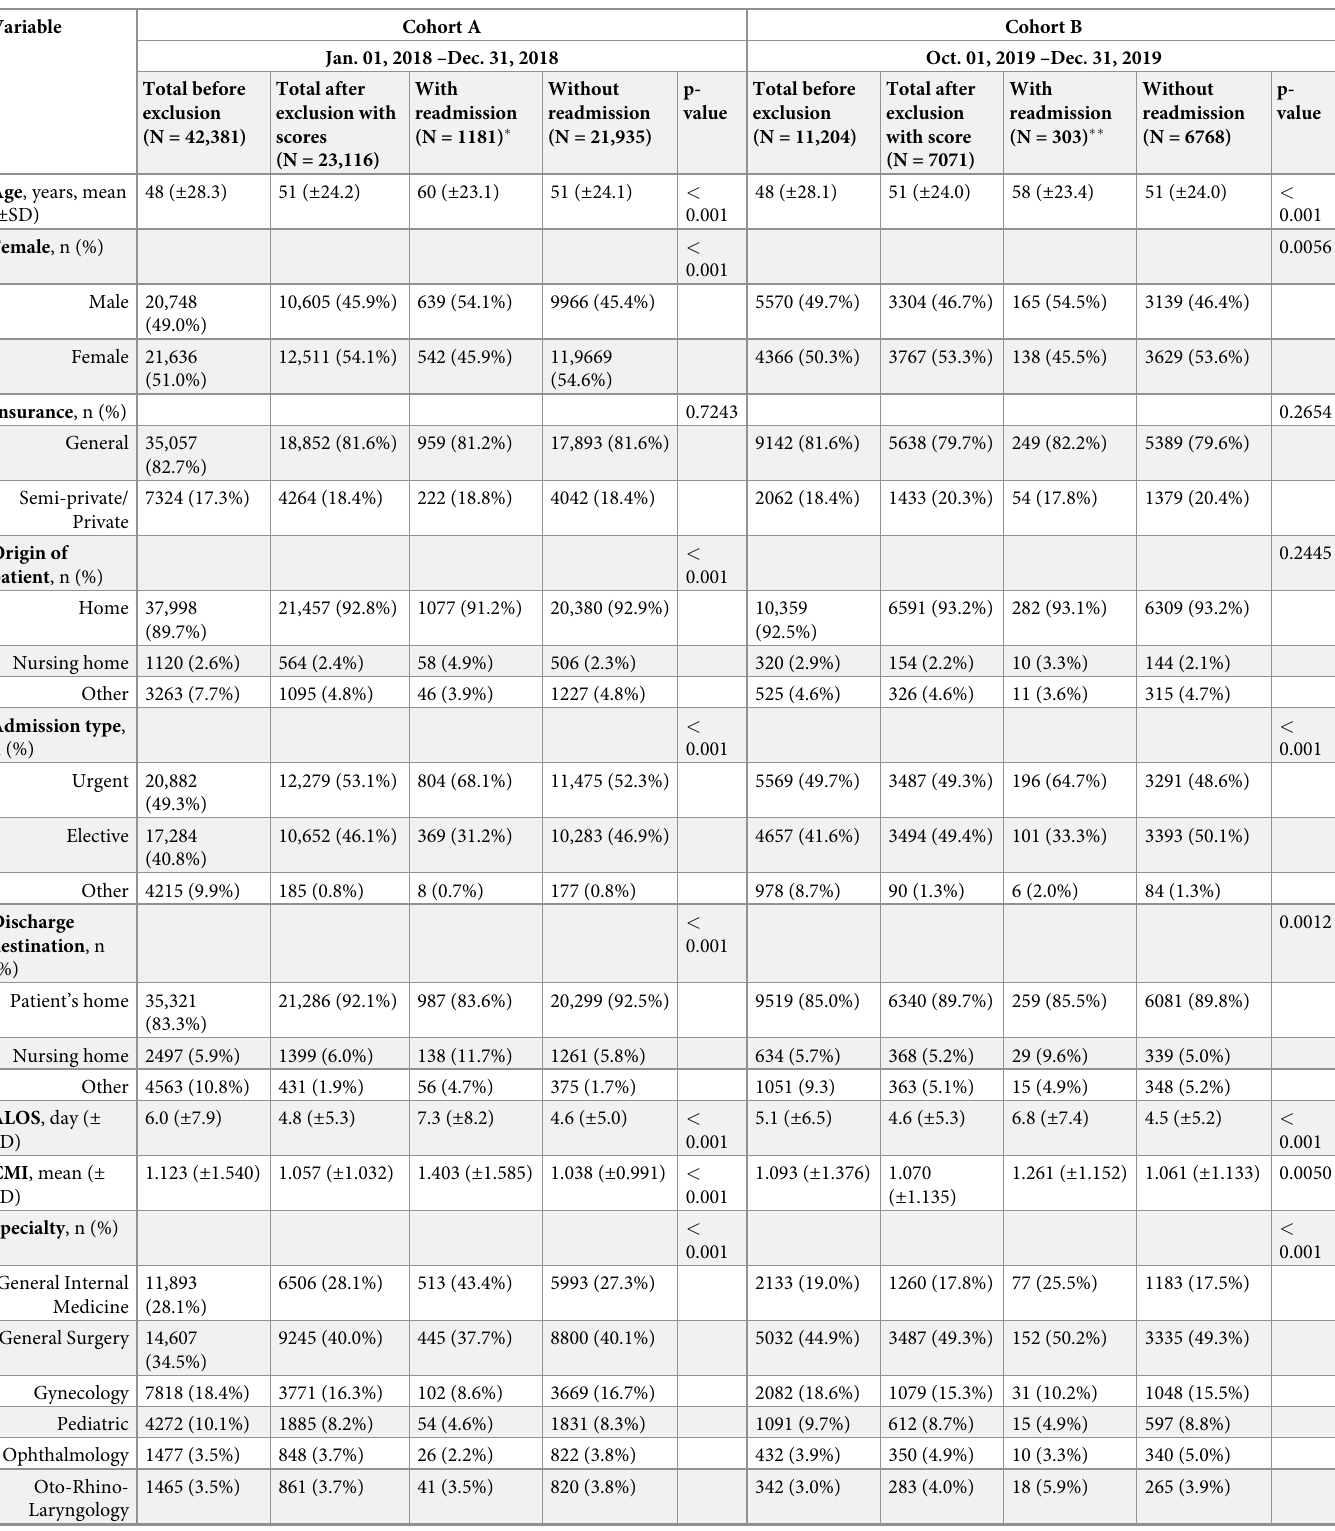
Table 4. Baseline